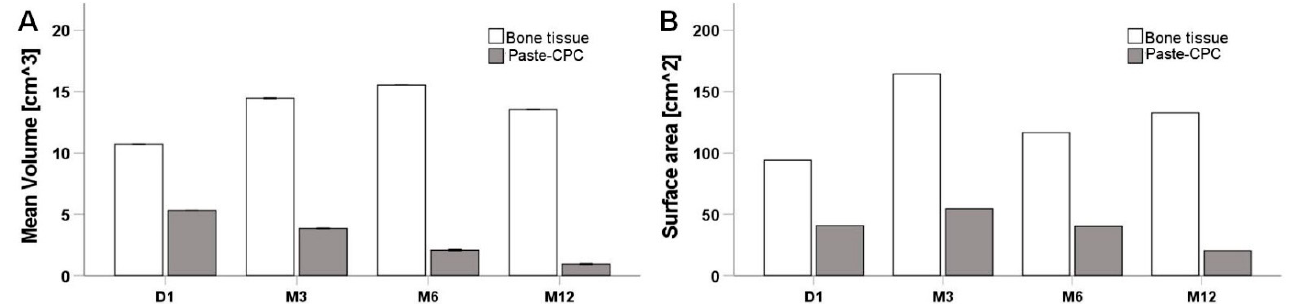
Figure 8. Degradation of bone cement is evaluated in the jaw. ( A ) Paste-CPC volume was reduced with the progression of the healing. ( B ) Surface area did not reflect the degradation of the material until M12.